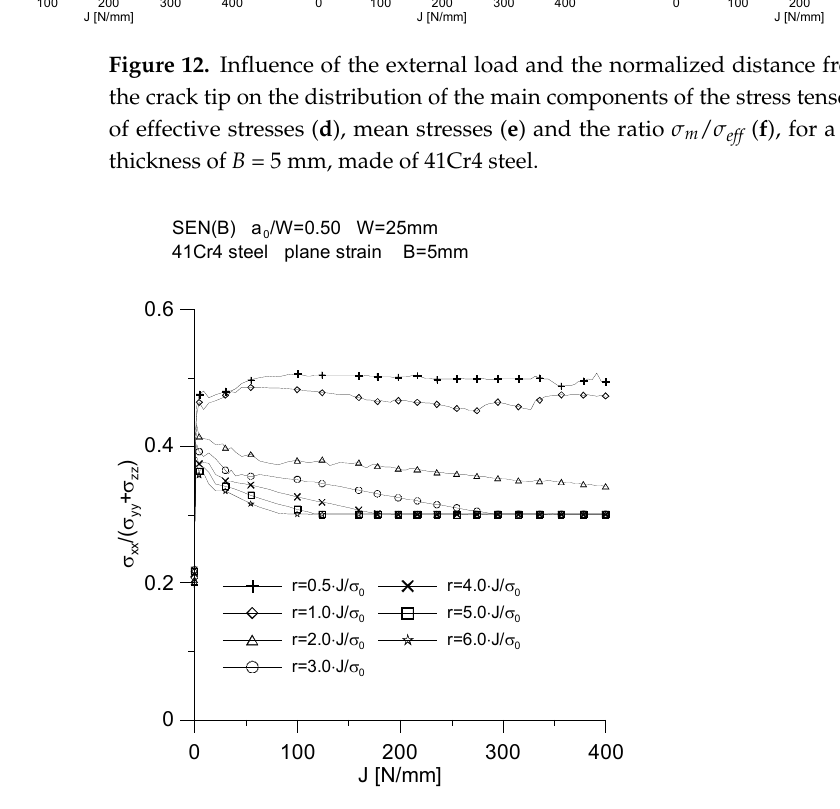
Figure 13. Influence of the external load and the normalized distance from the initial position of the crack tip on the distribution of the stress triaxiality coefficient, σ xx /( σ zz + σ yy ), for the SEN(B) specimen with a thickness of B = 5 mm, made of 41Cr4 steel.